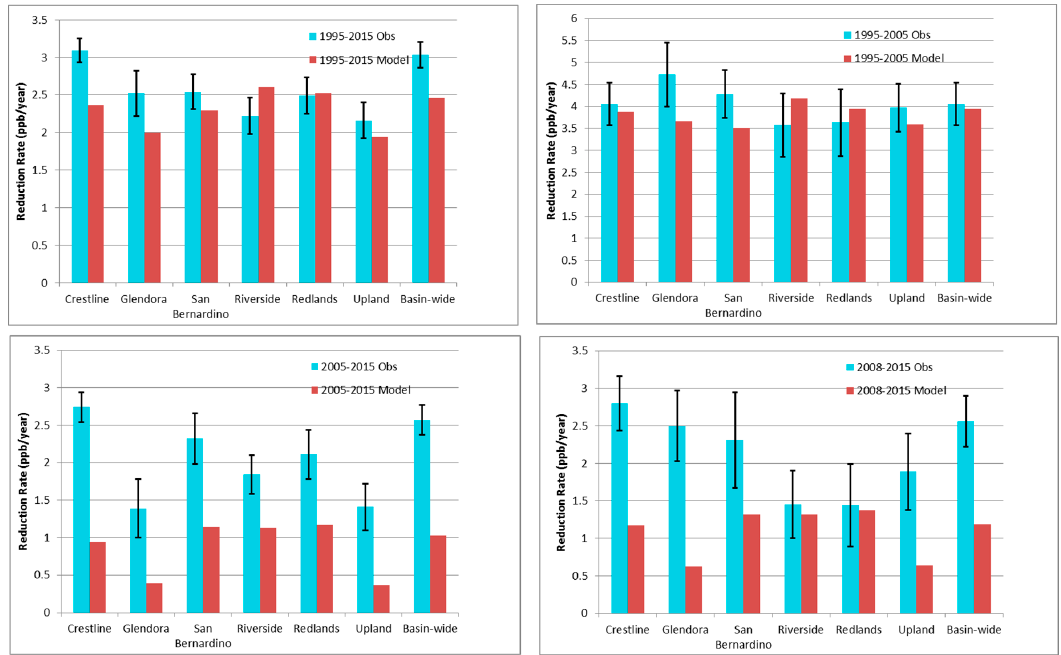
Figure 10. Multi-year modeled and observed reduction rates of 3-year ozone design values at selected monitors using the 2016 AQMP modeling database for the periods from 1995 to 2015 ( top left ), 1995 to 2005 ( top right ), 2005 to 2015 ( bottom left ), and 2008 to 2015 ( bottom right ). The observed rates include error bars to indicate the uncertainty in their calculation.